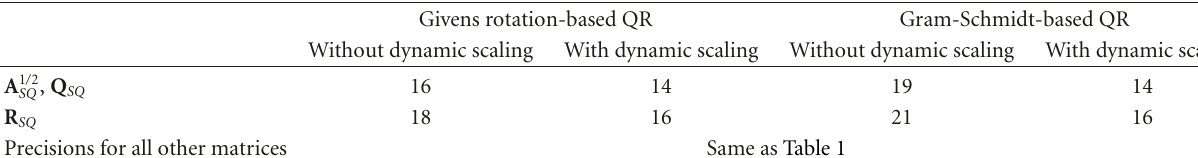
Table 4: Required bit precisions of QR decomposition for Square-Root detection.